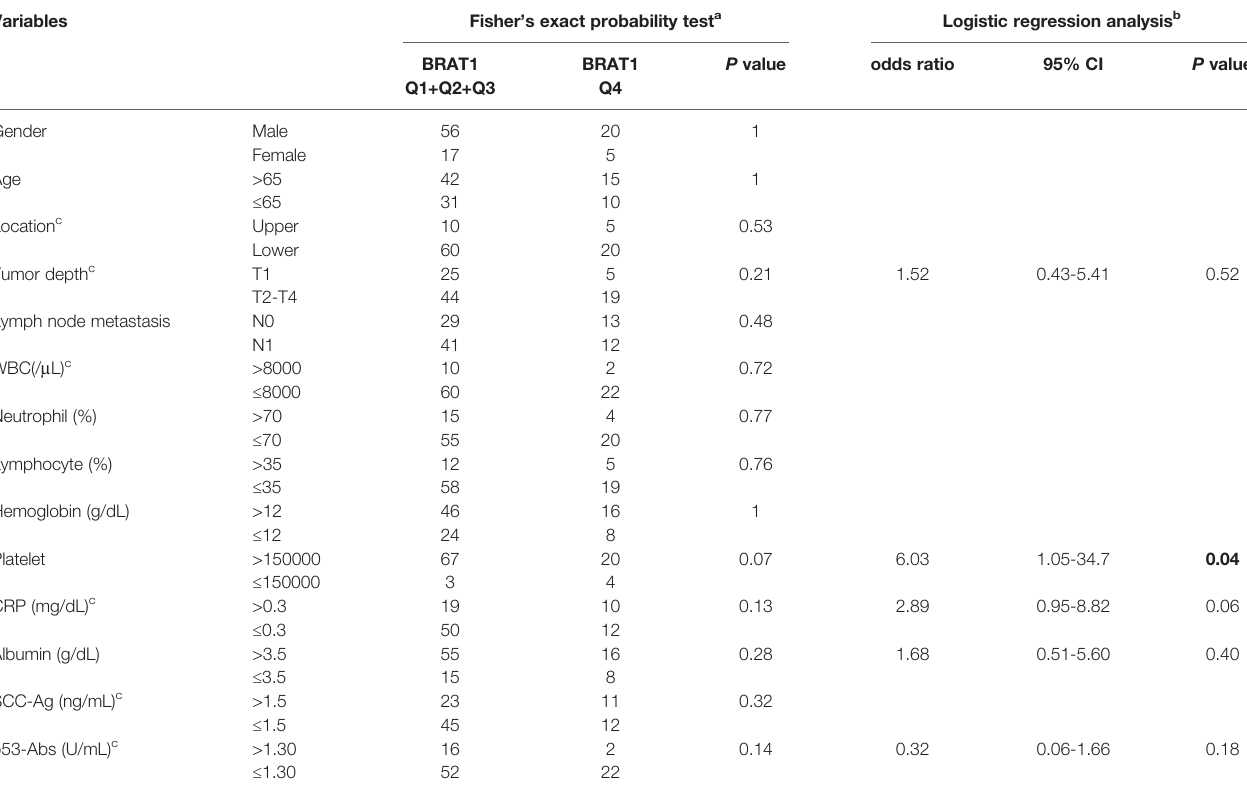
TABLE 6 | Comparison of serum BRAT1-Abs levels quartiles according to clinicopathological characters of the patients with ESCC. Variables Fisher ’ s exact probability test